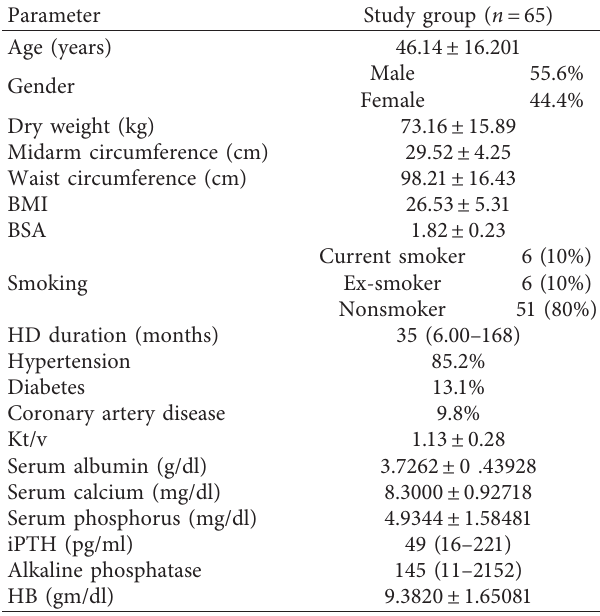
kg: kilogram; cm: centimeter; BMI: body mass index; BSA: body surface are; Kt/v: kinetic time over volume; gm/dl: gram/deciliter; mg/dl: milligram/ deciliter; iPTH: intact parathyroid hormone; pg/ml: picogram/millimeter; HG: